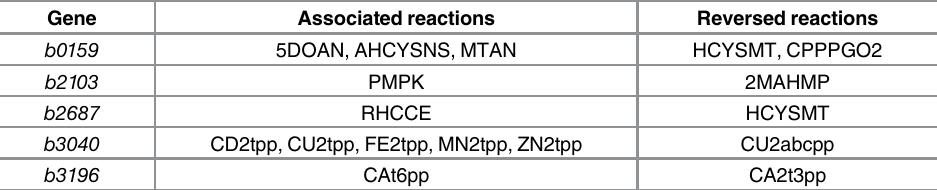
Table 6. Reversal of reactions of the E . coli network suggested by GlobalFit to remove FNp.